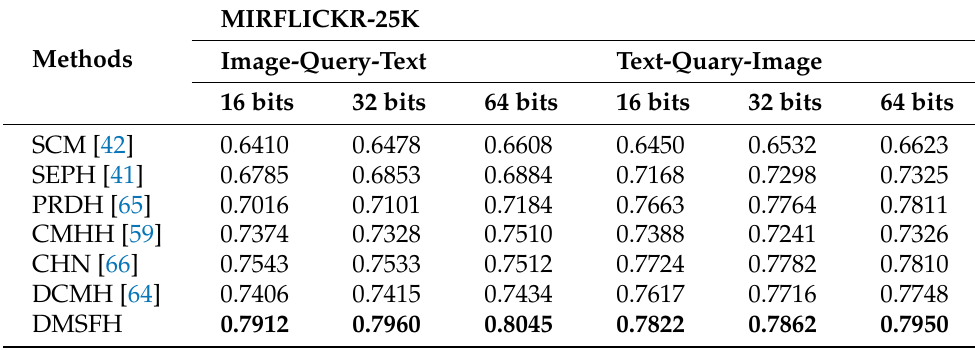
Table 3. Mean average precision (MAP) comparison on MIRFLICKR-25K. The best results are in bold font.